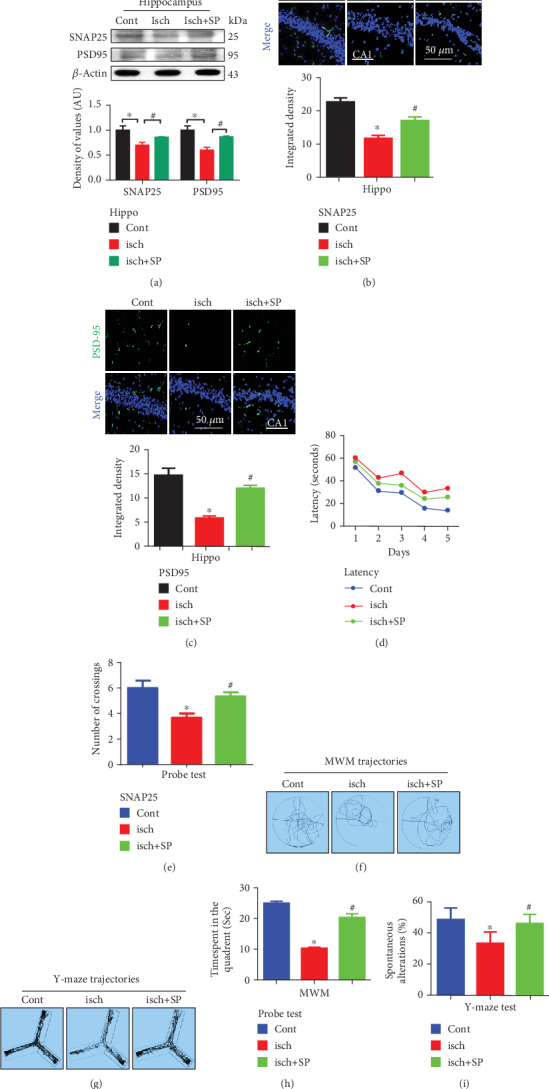
Chronic ischemic condition decreases synaptic proteins and induces memory dysfunction. (a) Represents the western blot results of synaptic markers hippocampus of adult mice. (b, c) Immunofluorescence analysis of synaptic proteins. (d, h, e, i) Indicating the water maze and Y-maze results while (f, g) specify the water maze and Y-maze trajectories, respectively.